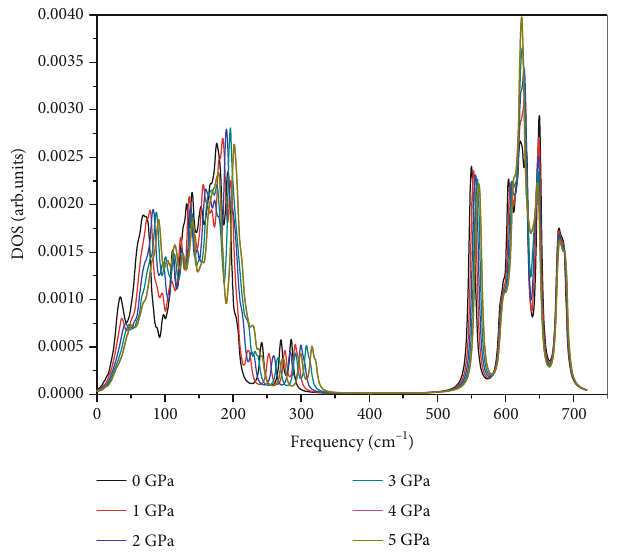
Figure 8: The total phonon density of states (TDOS) of orpiment As S under 2 3